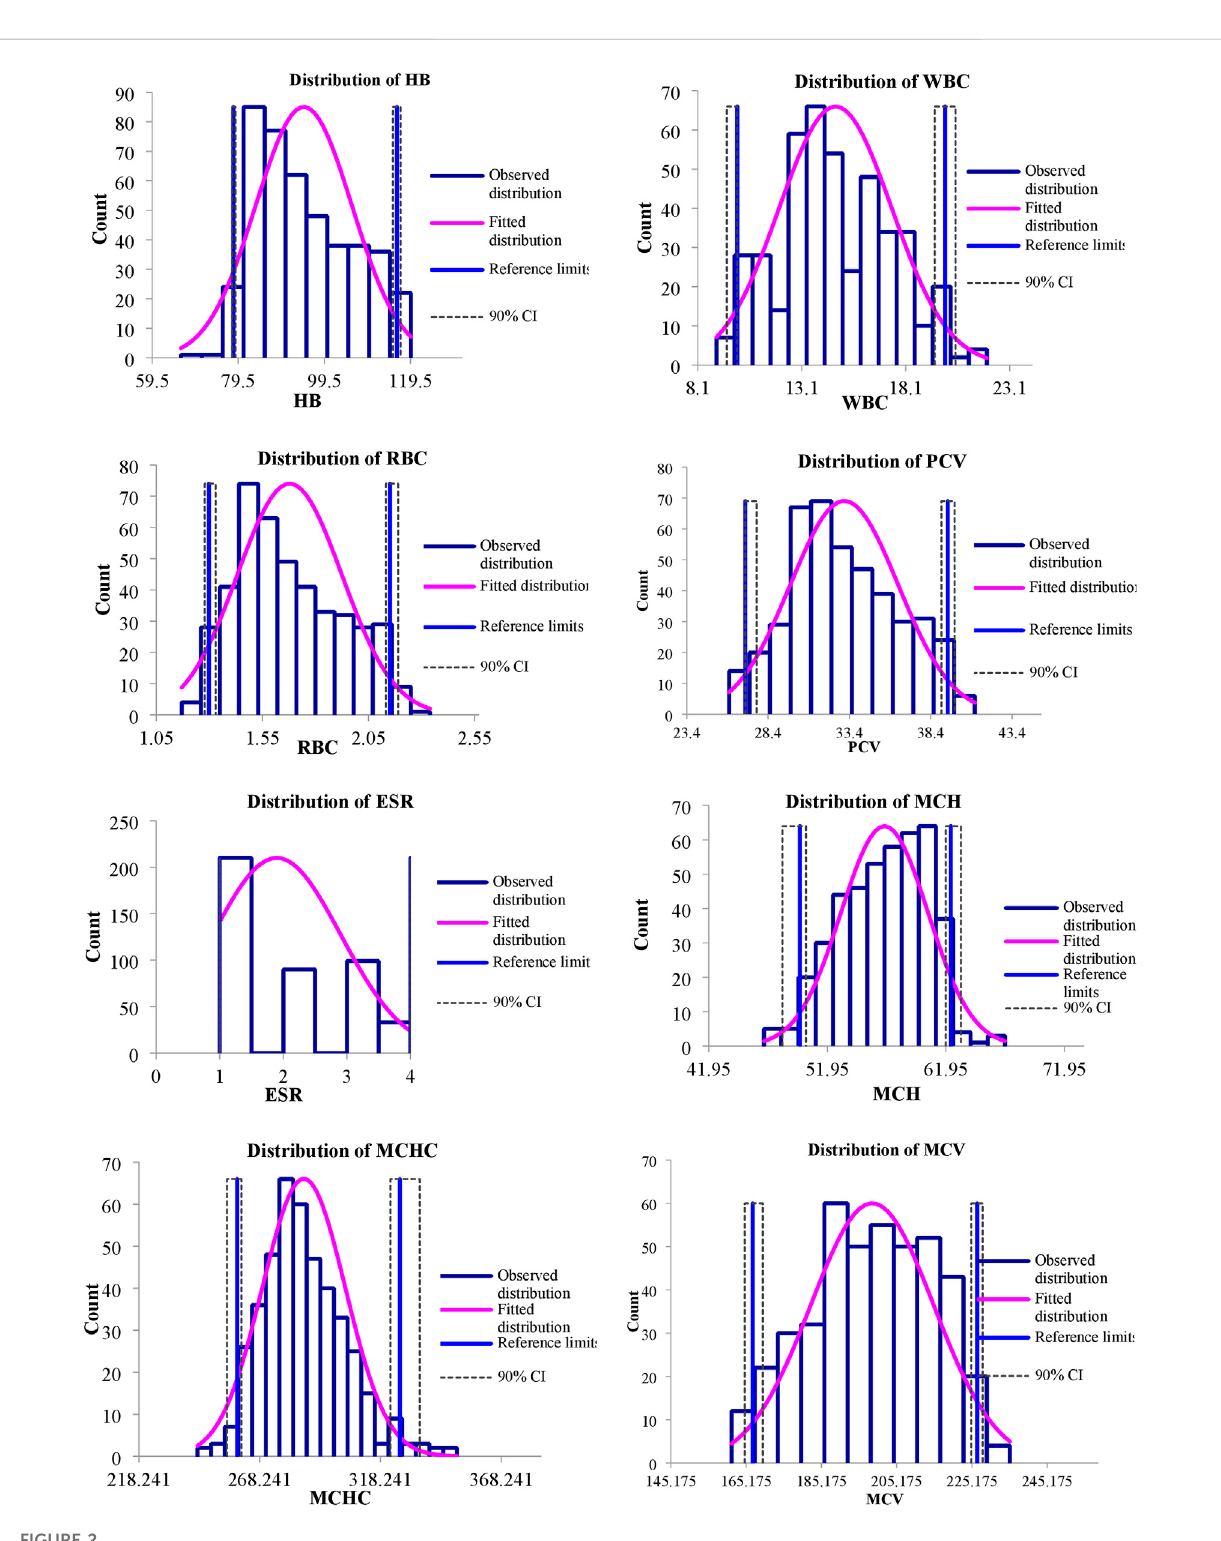
FIGURE 2 Representing distribution of hematological reference intervals of S. esocinus from River Jhelum.